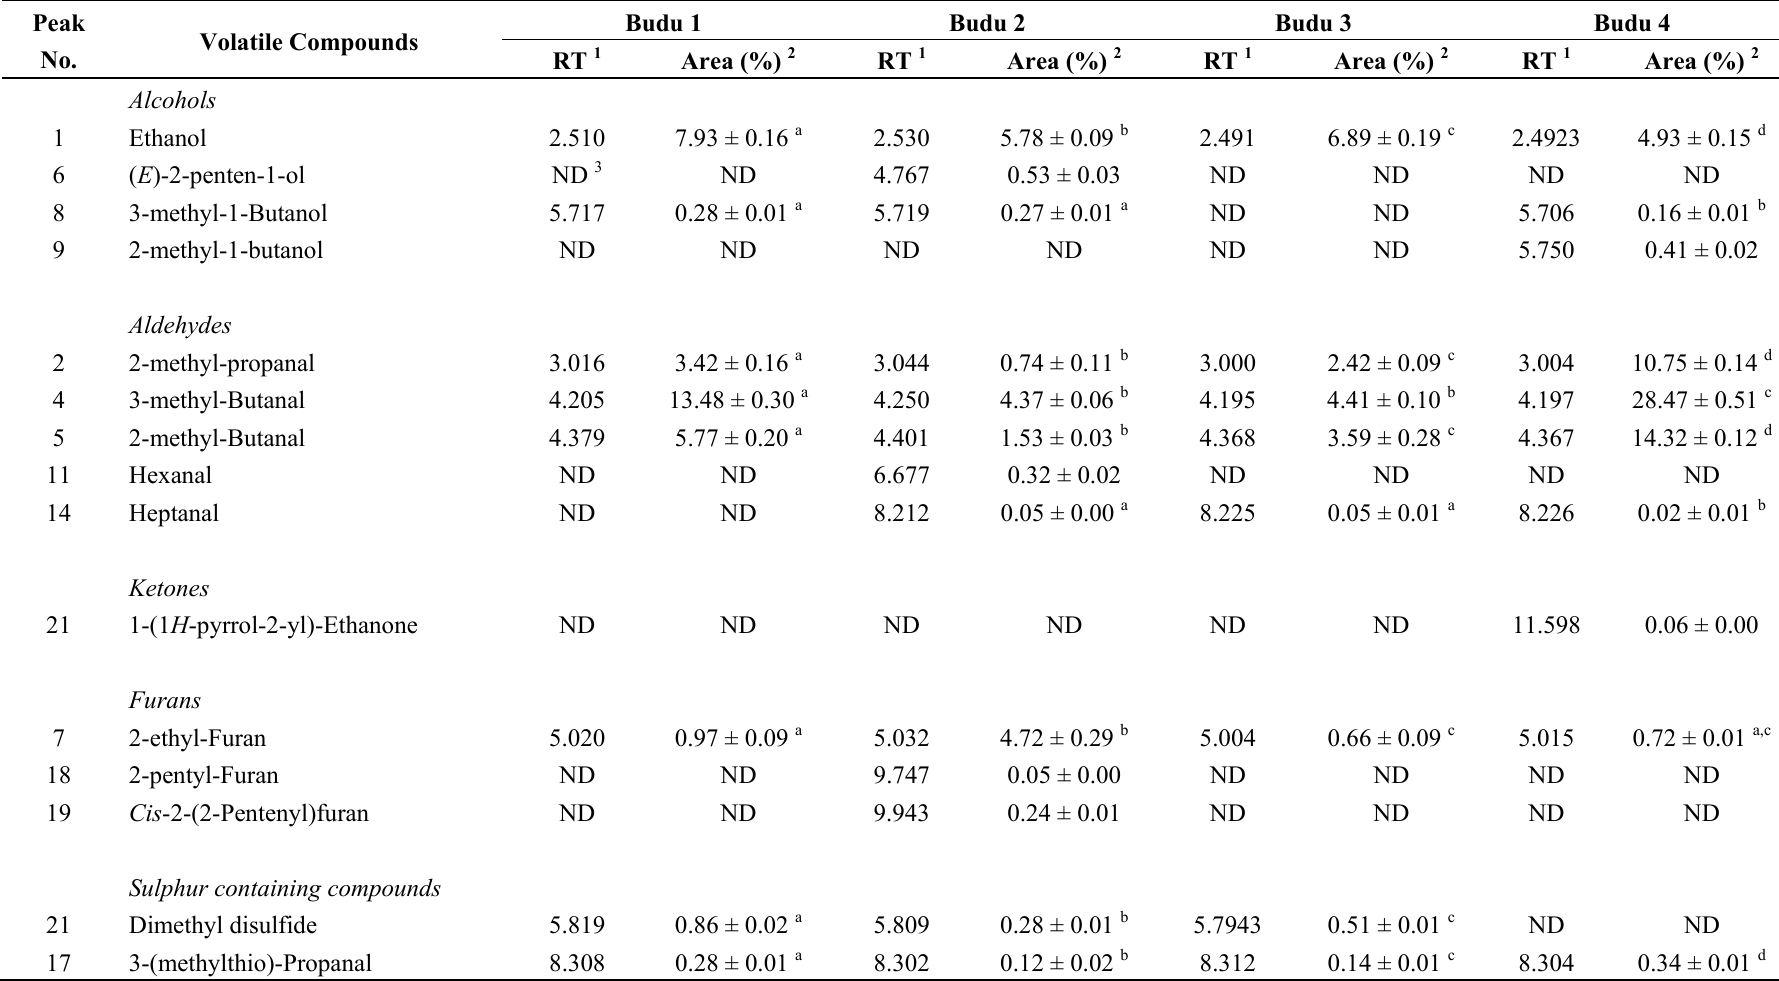
Table 4. Retention time and percentage of area of volatile compounds detected in four Budu samples by using HP-5MS